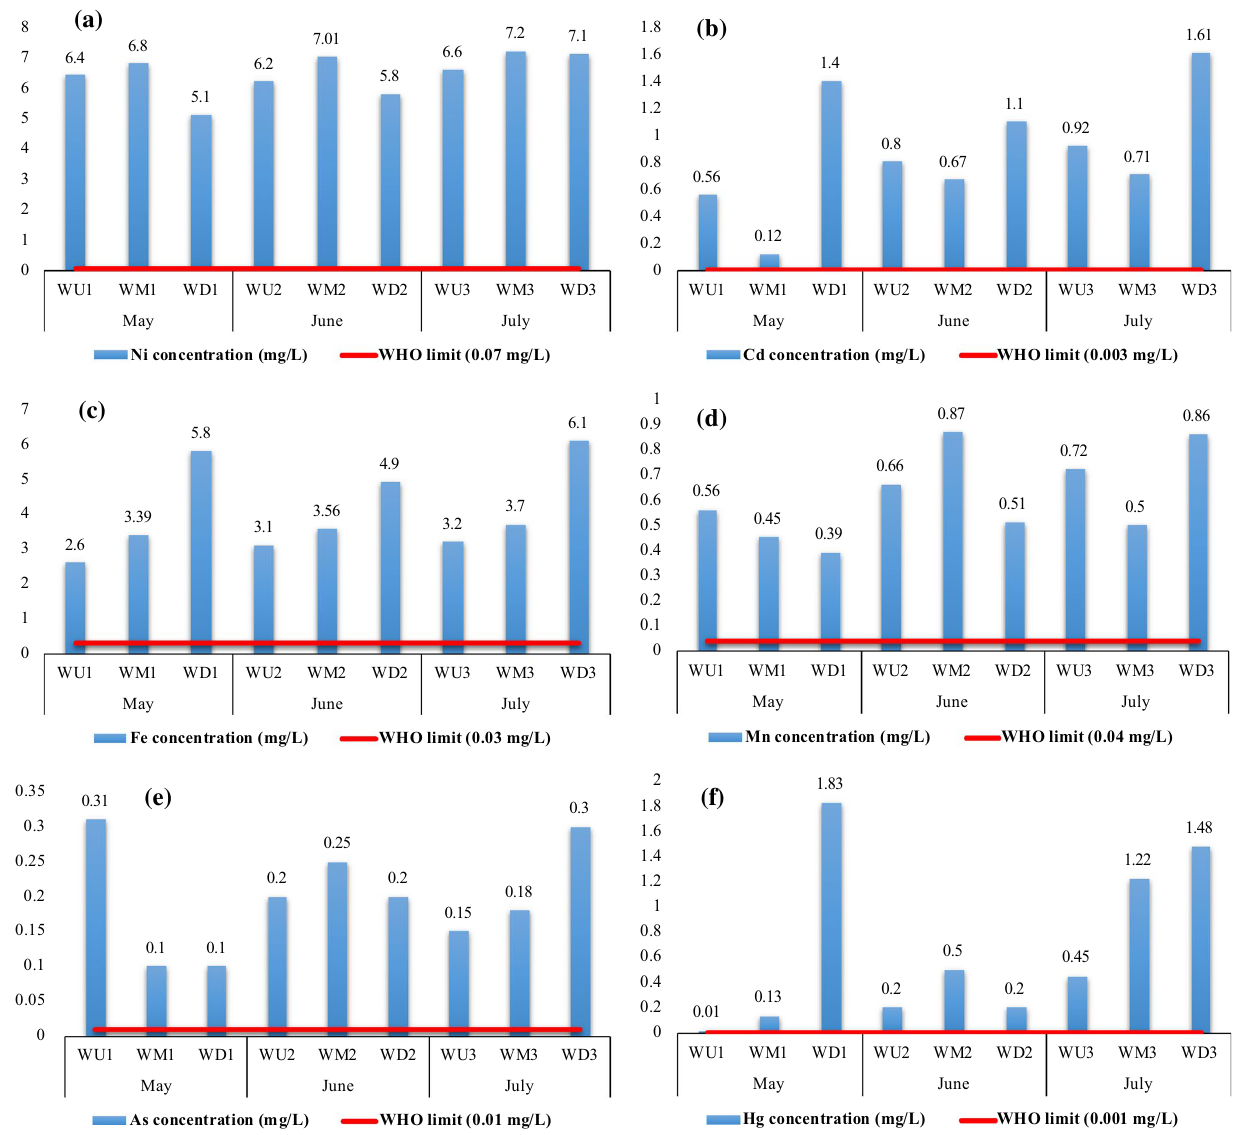
Fig. 5 Spatiotemporal variations in heavy metals concentrations in water samples: a Nickel; b Cadmium; c Iron; d Manganese; e Arsenic and f Mercury. WU: Usptream sample; WM: Sample collected in the middle of the mining site; WD: Downstream